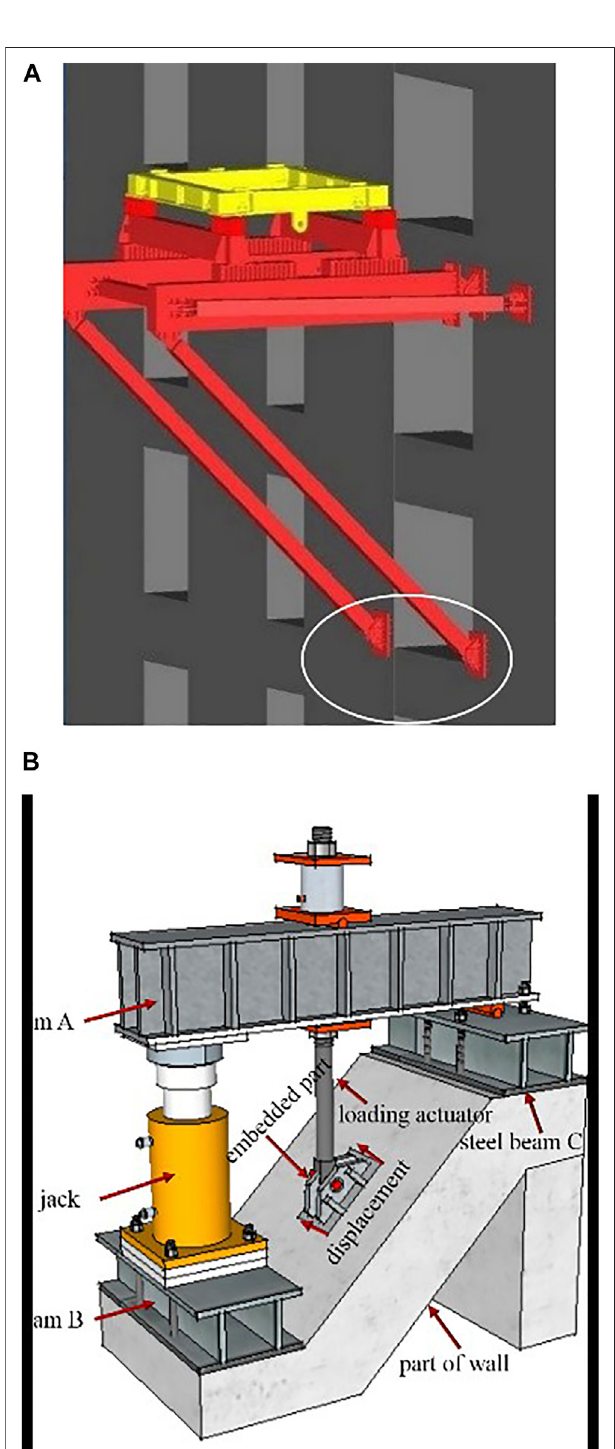
FIGURE 3 | Simpli fi ed BFJ and test device: (A) BFJ in construction, (B) test